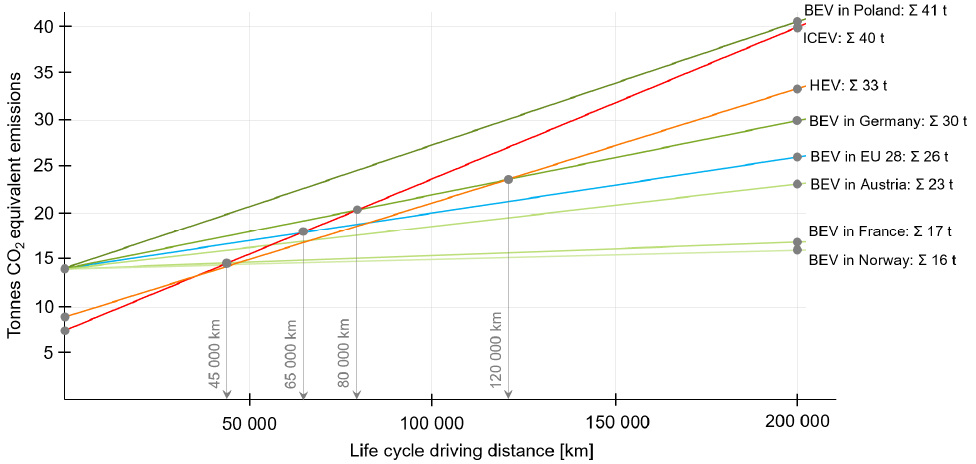
Figure 16. Life-cycle CO 2 -equivalent emissions of compact cars with different propulsion systems and exemplarily varied carbon footprints of electric-power generation.